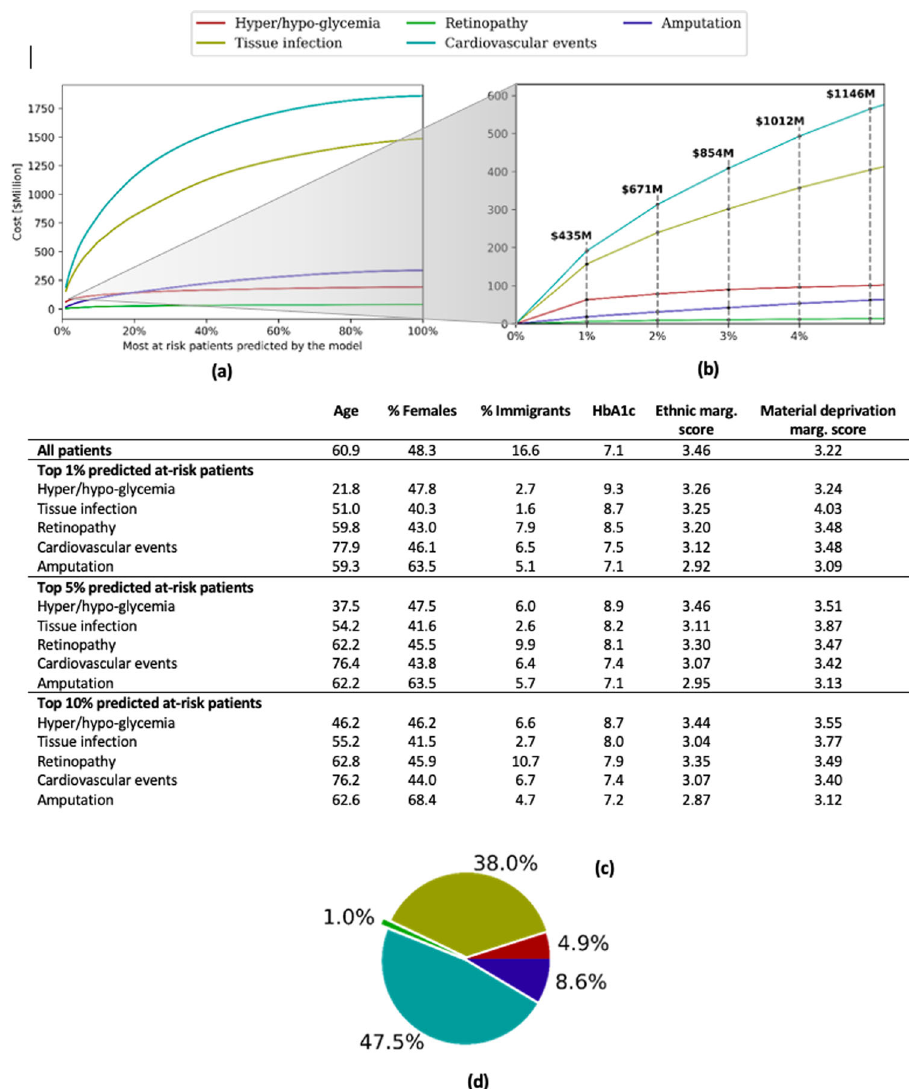
Fig. 4 Adverse outcome cost analysis and high-risk statistics across complications. The total annual cost for adverse outcomes across all fi ve complications is estimated to be ~$3.9B. a Annual cost for most at-risk patients predicted by our model. For each complication, we sort all patients by the predicted likelihood of adverse outcome, then compute total cost for each percentage of patients in the sorted list from top 1 – 100%. b A detailed sub-view from panel a for top 5% of predicted patients with the total cost across all six complications. c Statistics for the top 1% of most at risk patients predicted by our model. We analyze age, sex, immigration status, and HbA1c values, and compare them to the full cohort. All statistics are computed at the end of the observation window for each patient when the model makes its prediction. d Breakdown of the contribution to the total annual cost by